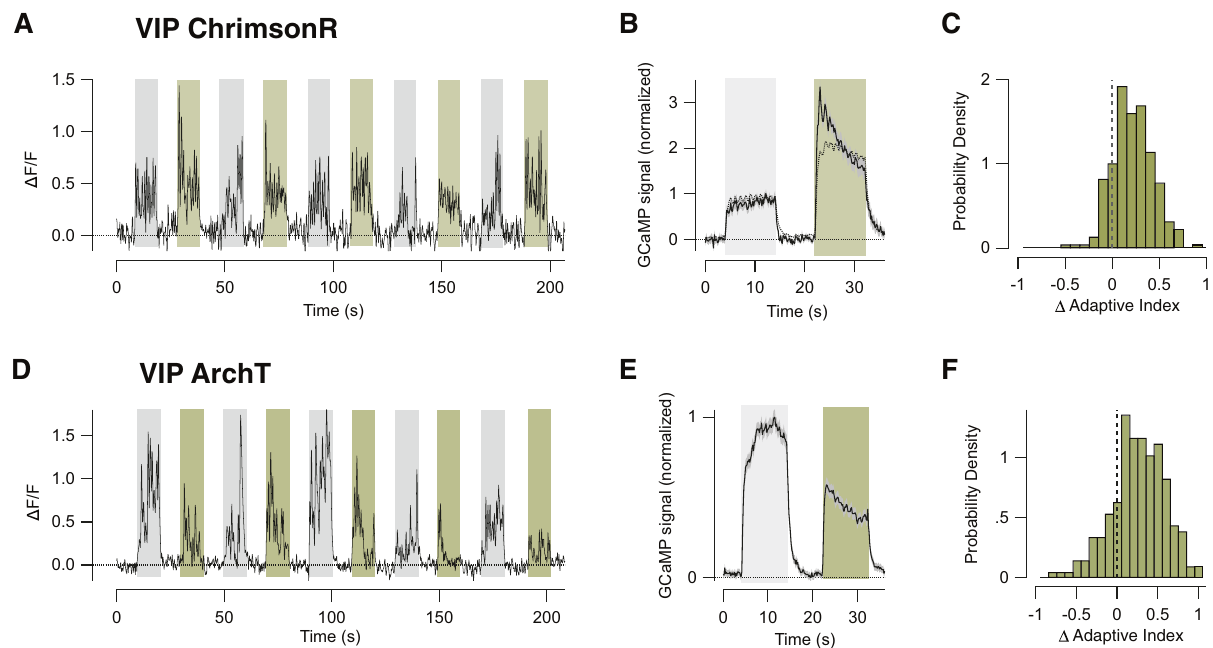
Fig. 6 VIP interneurons drive sensitization of pyramidal cells. A An example of the response of a PC when optogenetically activating VIP interneurons expressing ChrimsonR. Stimulus trials with LED illumination (green bars) and without (grey bars) were interleaved. Increasing activity of VIP cells increased the initial gain of PCs, demonstrating effective disinhibition, which was followed by depressing adaptation. B Average of paired stimulus trials from experiments shown in A ( n = 3 mice, 414 cells). The solid trace shows the effect of 1 mW illumination power and the dashed trace 0.06 mW. Note that the lower level of photoactivation caused a smaller increase in the initial amplitude of the response and a smaller shift to depressing adaptation. C The distribution of changes in adaptive index in PCs during VIP cell activation. The shift towards positive values (depression) was signi fi cant at p = 10 − 6 (WSR test). D An example of the response of a PC when optogenetically inhibiting VIP interneurons expressing ArchT. E Average of paired stimulus trials from experiments shown in D ( n = 3 mice, 421 cells). F Distribution of changes in AI of PCs during VIP neuroninhibition. The distribution was shifted towards depressing adaptation (signi fi cant at p = 10 − 7 ; WSR test). Data are represented as mean ± SEM (grey shading area in B , E ) or probability density ( C , F ). Source data are provided as a Source Data fi